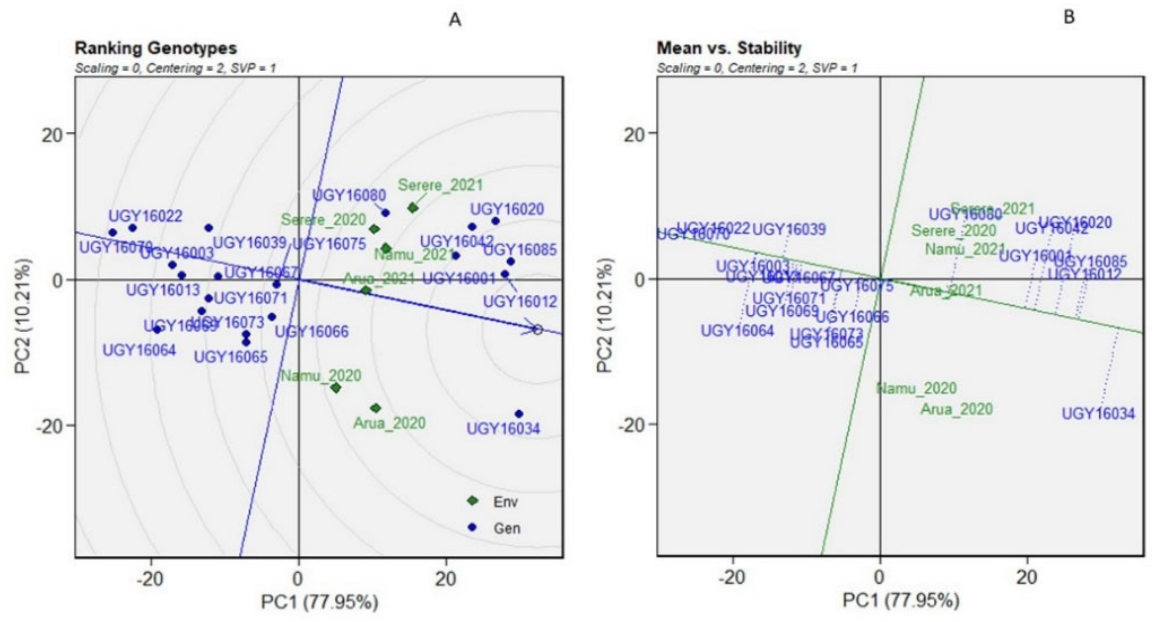
Figure 6. GGE ranking biplot showing the mean ( A ) overall performance and ( B ) stability for total yield of yams (kg/plot) of 20 yam genotypes evaluated in six environments.